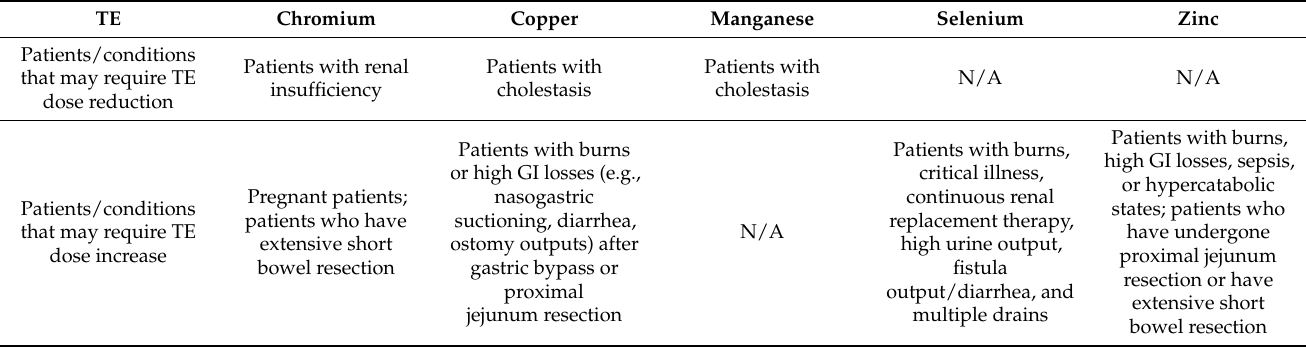
Table 5. Factors that may affect TE needs of patients receiving PN